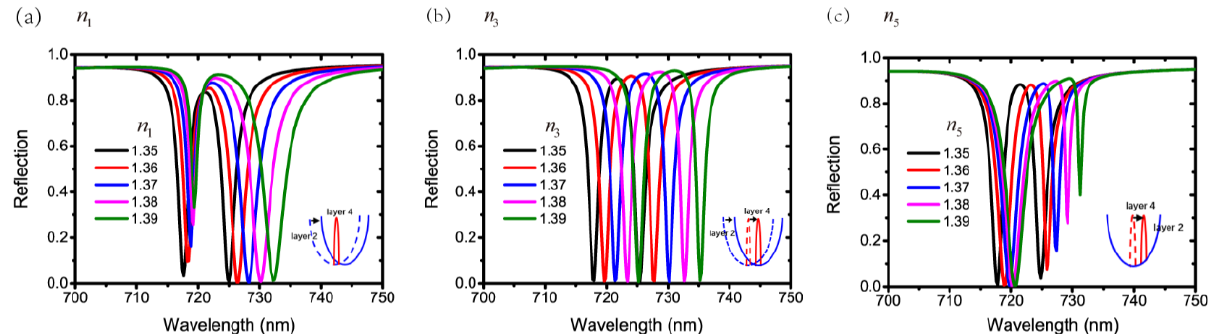
substrate is next to layer 4. Consequently, a redshifted waveguide resonance in layer 4 and an unchanged waveguide resonance in layer 2 result in a Fano resonance on the right falling edge in Figure 6c. If we increase n 3 , the two waveguide resonances in layer 2 and layer 4 both redshift. Hence, the EIT-like effect still appears at a longer wavelength in Figure 6b. The schematic representations of the formation processes of Fano resonance and EIT-like effect with the increasing refractive indices are shown in the insets of Figure 6a–c.